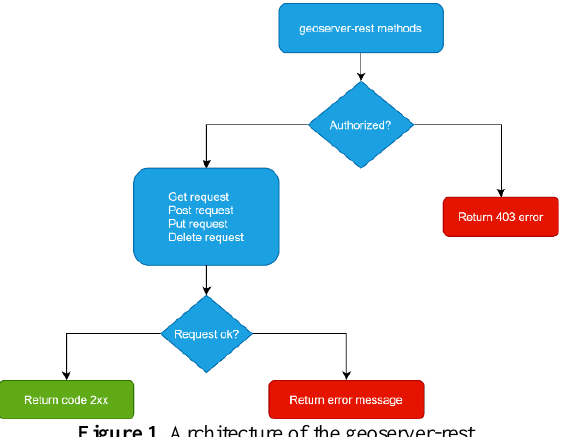
Figure 1. Architecture of the